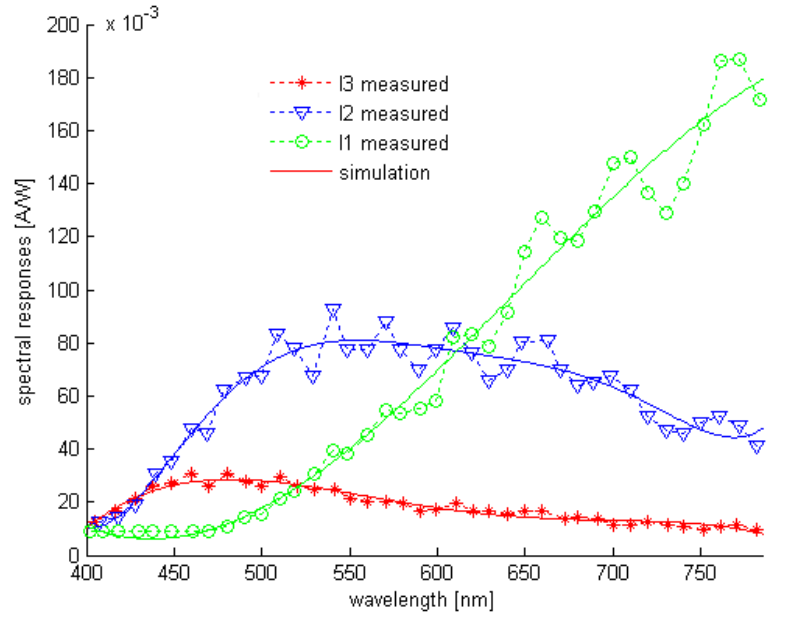
Figure 2. BTJ Spectral responses